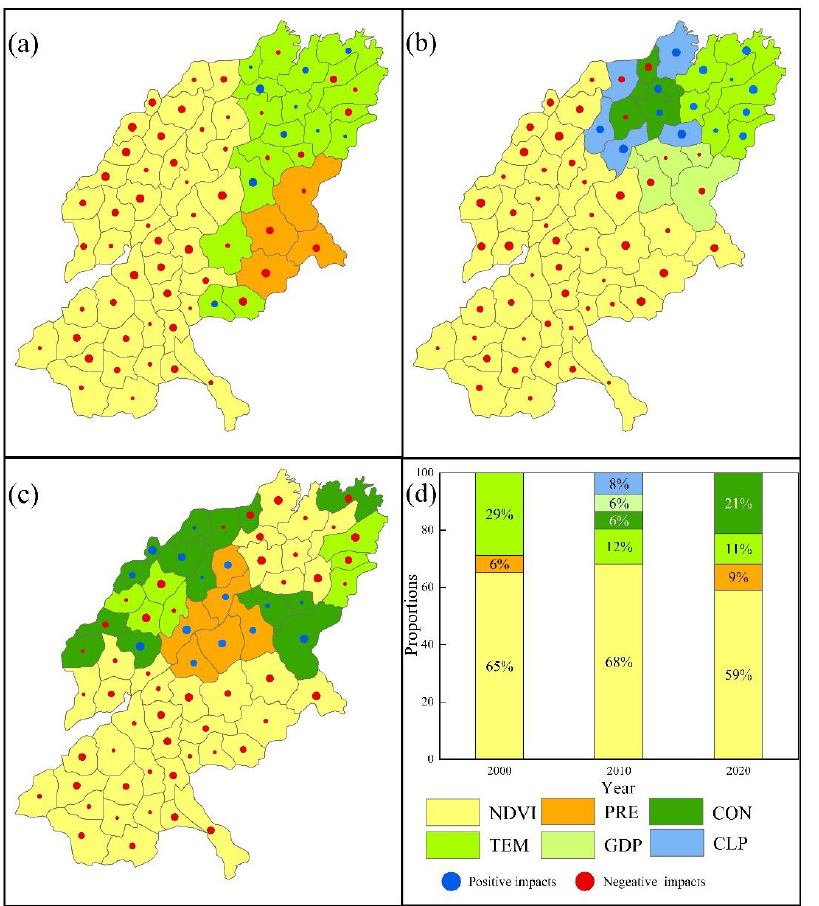
Figure 10. ESs’ trade-off drivers in different cities of FP_HQ (( a ) in 2000; ( b ) in 2010; ( c ) in 2020). ( d ) Proportion of area accounted for by key ES trade-off drivers in different years (Refer to Tables 2 and 3 for the meanings of each symbol ).